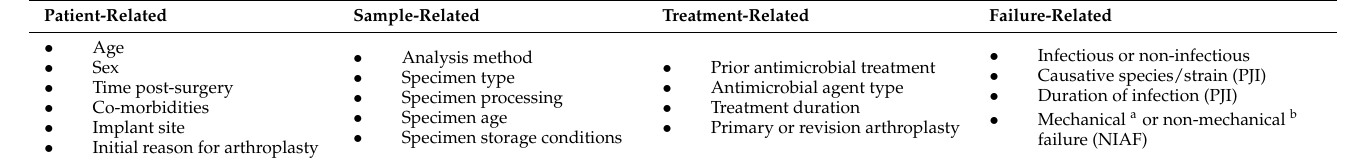
Table 4. Variables to consider when profiling the immune response to arthroplasty